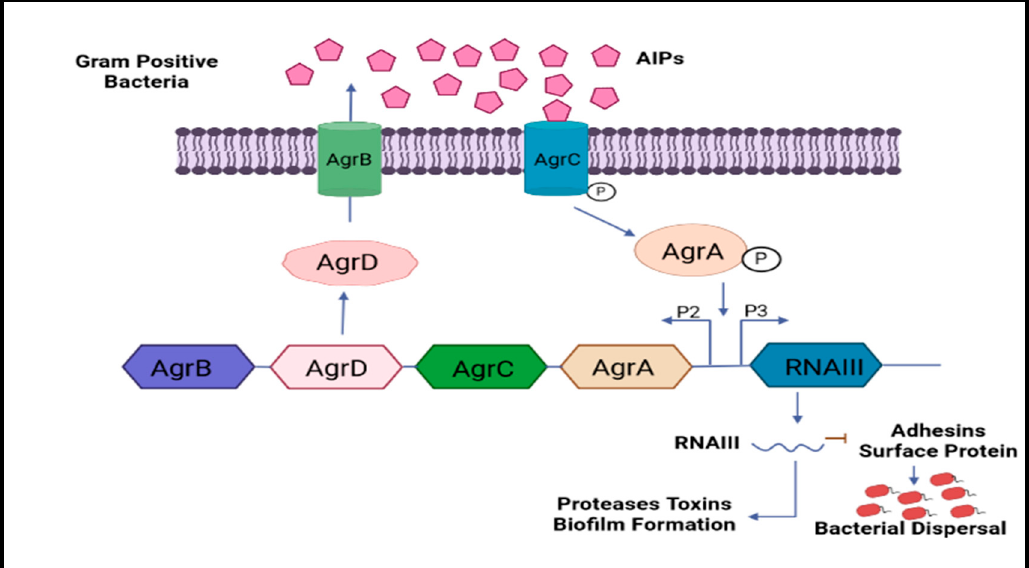
Figure 4. Shows the involvement of Gram-positive bacteria’s classical QS signalling molecules and their role in biofilm development. The common QS signalling system is